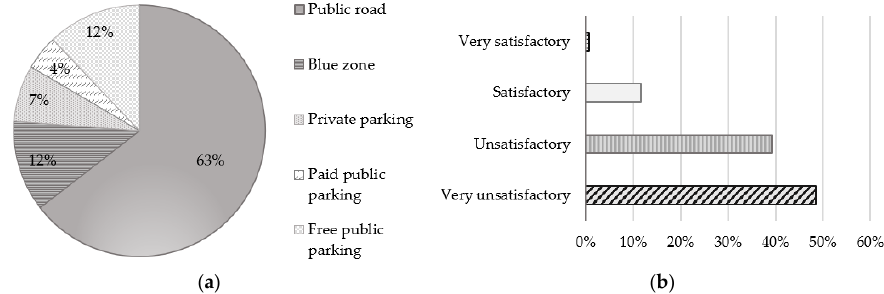
Figure 9. Parking situation in Cáceres. ( a ) Parking place at destination of journeys; ( b ) Parking facilities in Cáceres.